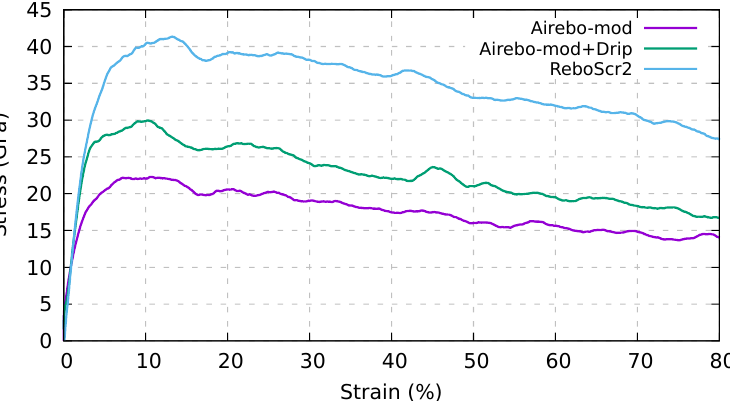
Figure 10. Pull-out stress for the central nanotube from the seven (6,6) CNT bundles with different potentials at a constant pull-out velocity of 1.0 Å/ps. The ReboScr2 potential overestimates the pull- out stress by a factor of two with respect to AIREBO-mod, and by 25% using the (AIREBO-mod+DRIP) interaction